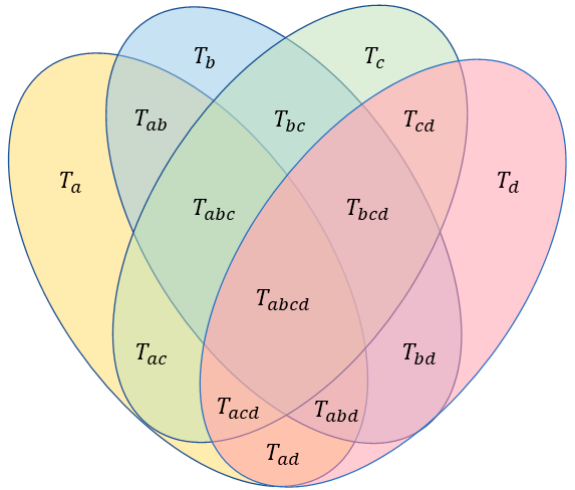
7 of 22 Figure 3. Mechanism of the coupling of safety risks in tunneling construction (source: plo tt ed with reference to [37]). According to the tunnel construction risk itself, the tunnel construction safety risk coupling type can be divided into homogeneous single-factor coupling risk, heterogene- ous two-factor coupling risk and heterogeneous multifactor coupling risk; tunnel con- struction safety risk factor coupling types are shown in Figure 4, where the factor coupling risk fl ow values expressed by T, such as 𝑇 (cid:3028)(cid:3029) , indicate the personnel–equipment risk factor coupling in the two-factor coupling risk. 1.